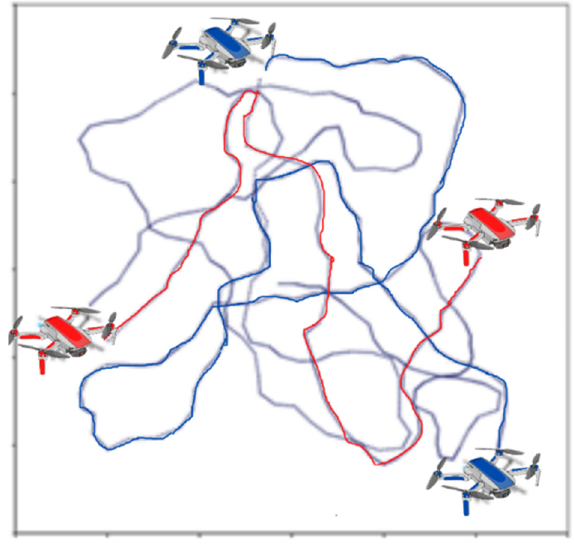
Figure 5. Example of UAV trajectory in the GM mobility model.